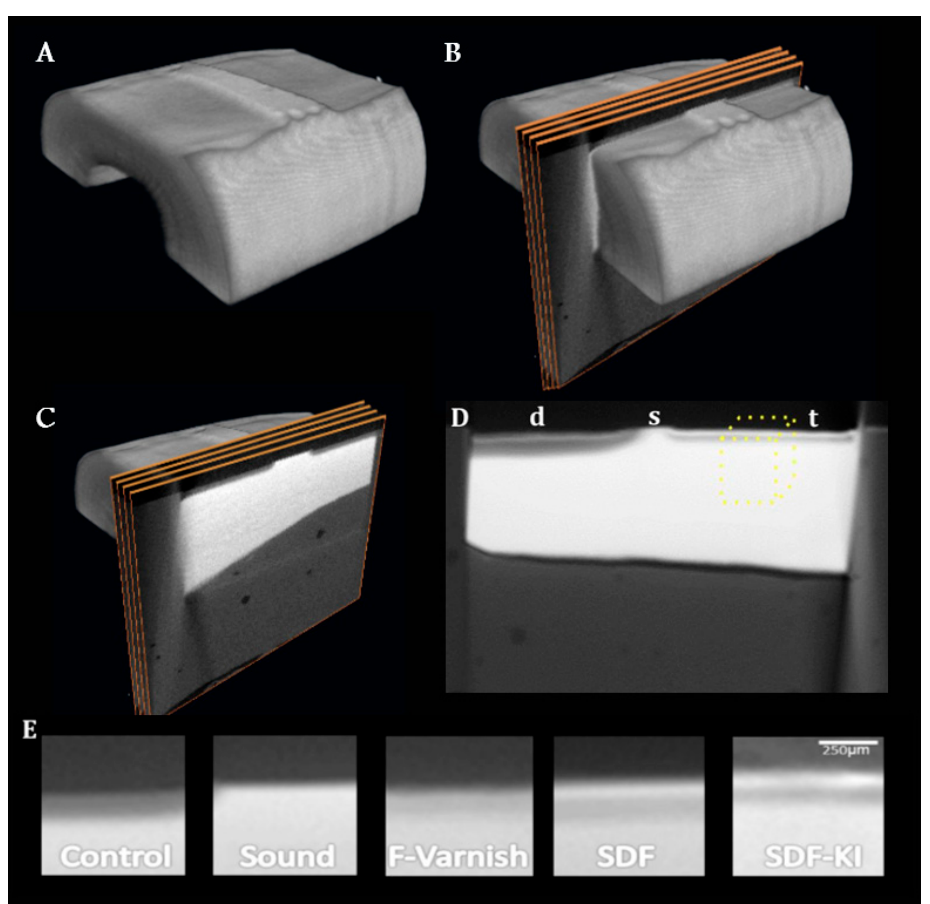
Figure 1. 3D reconstruction of images in Amira software and the results. ( A ) a root dentin block specimen scanned; ( B ) 100 slices were then selected from the middle of each specimen and averaged to one image; ( C ) representative slices on the 3D image; ( D ) the resulting average image. The volume of interest on the treatment window is highlighted with the dotted outline. The demineralized internal control (d), sound (s) and treated (t) areas are distinctly visible; ( E ) representative average slices used to calculate mineral density in each group.